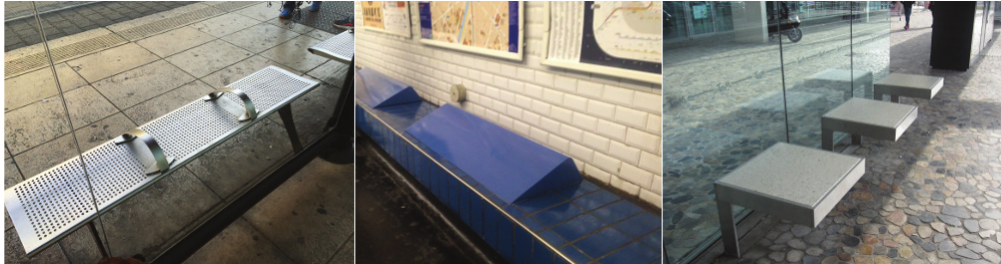
Figure 6. Examples of anti-homeless benches in Stalingrad Station, Paris Metro and bus shelters. Source: the authors. Urban Planning, 2019, Volume 4, Issue 2, Pages